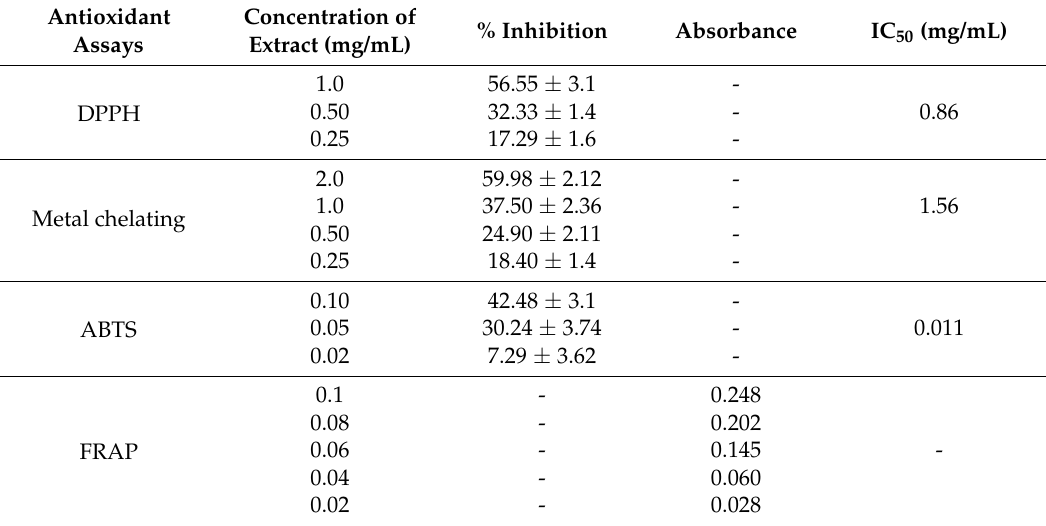
Table 2. Radical scavenging activity of ethyl acetate extract of Streptomyces sp.S2A.